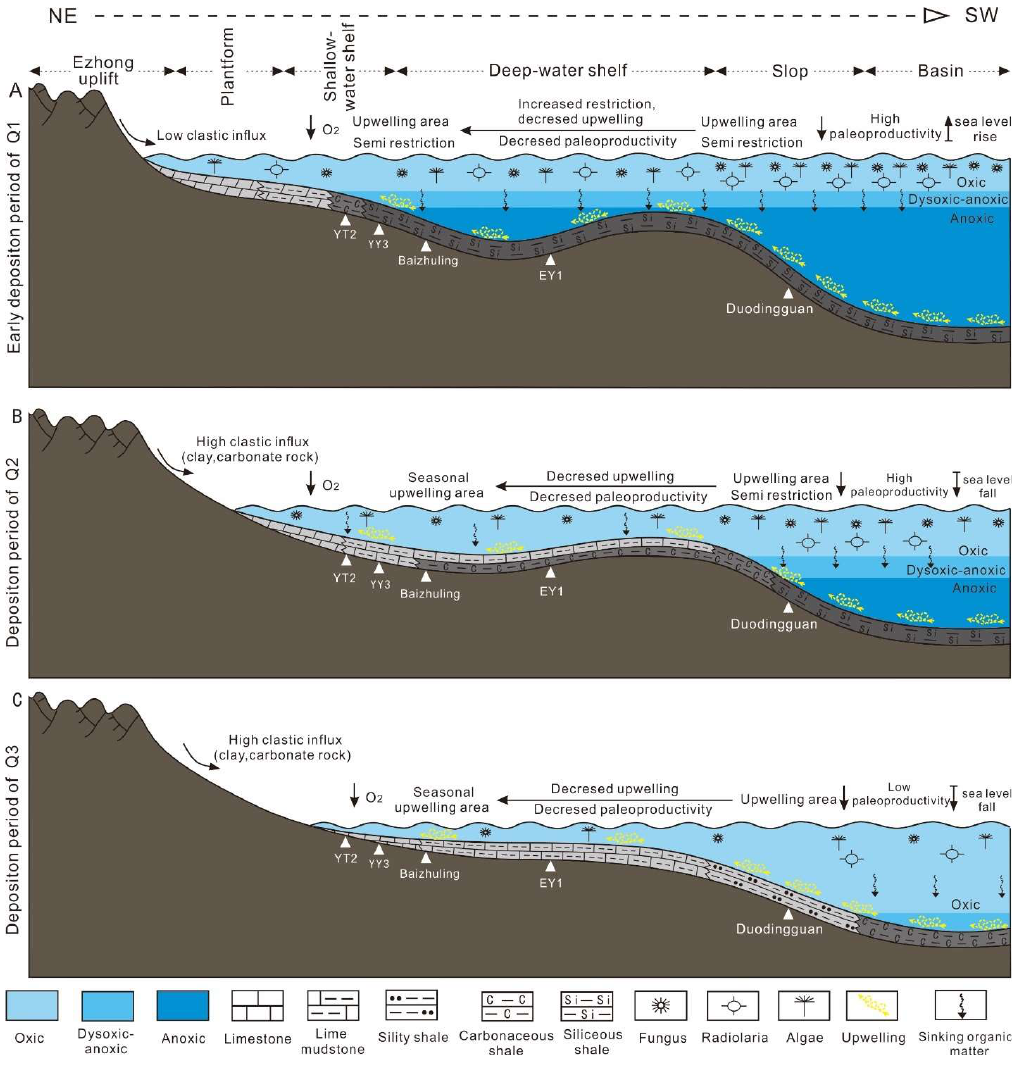
Figure 8. Organic matter enrichment models for the different deposition periods of the Lower Cambrian Qiongzhusi Formation in the western Middle Yangtze Block. During the middle to late stages of the deposition of Q1, the Yangzi re- gion was in the early stage of a slow marine regression, and the sea level was still high in the study area. The organic matter enrichment conditions in the different zones, as well as the zone-to-zone variations, remained consistent during the early deposition stage of Q1.